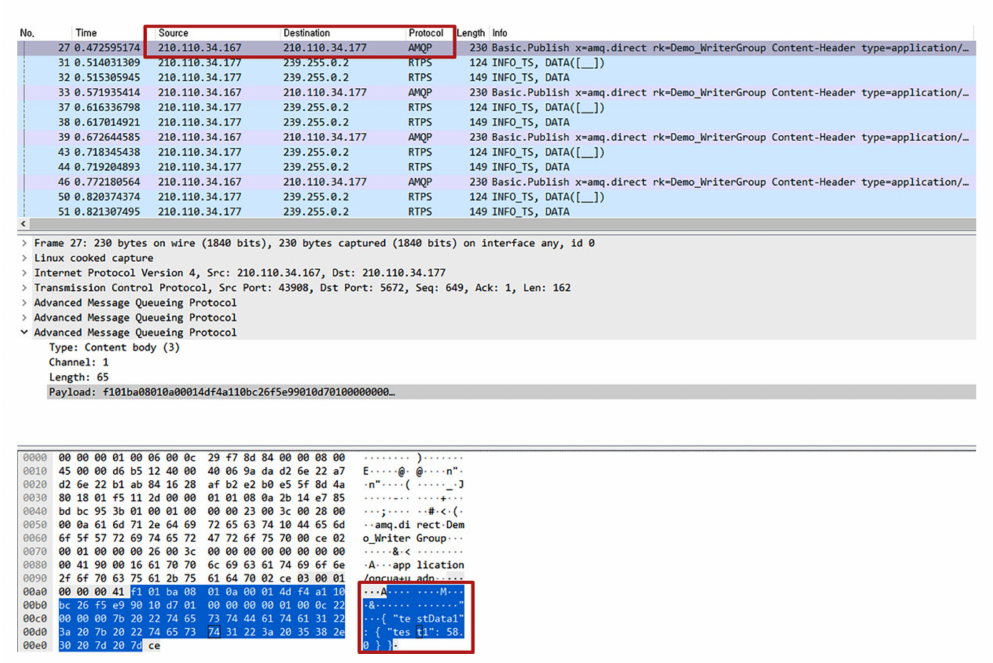
Figure 14. Monitoring screen between the OPC UA publisher and DDS gateway (AMQP).